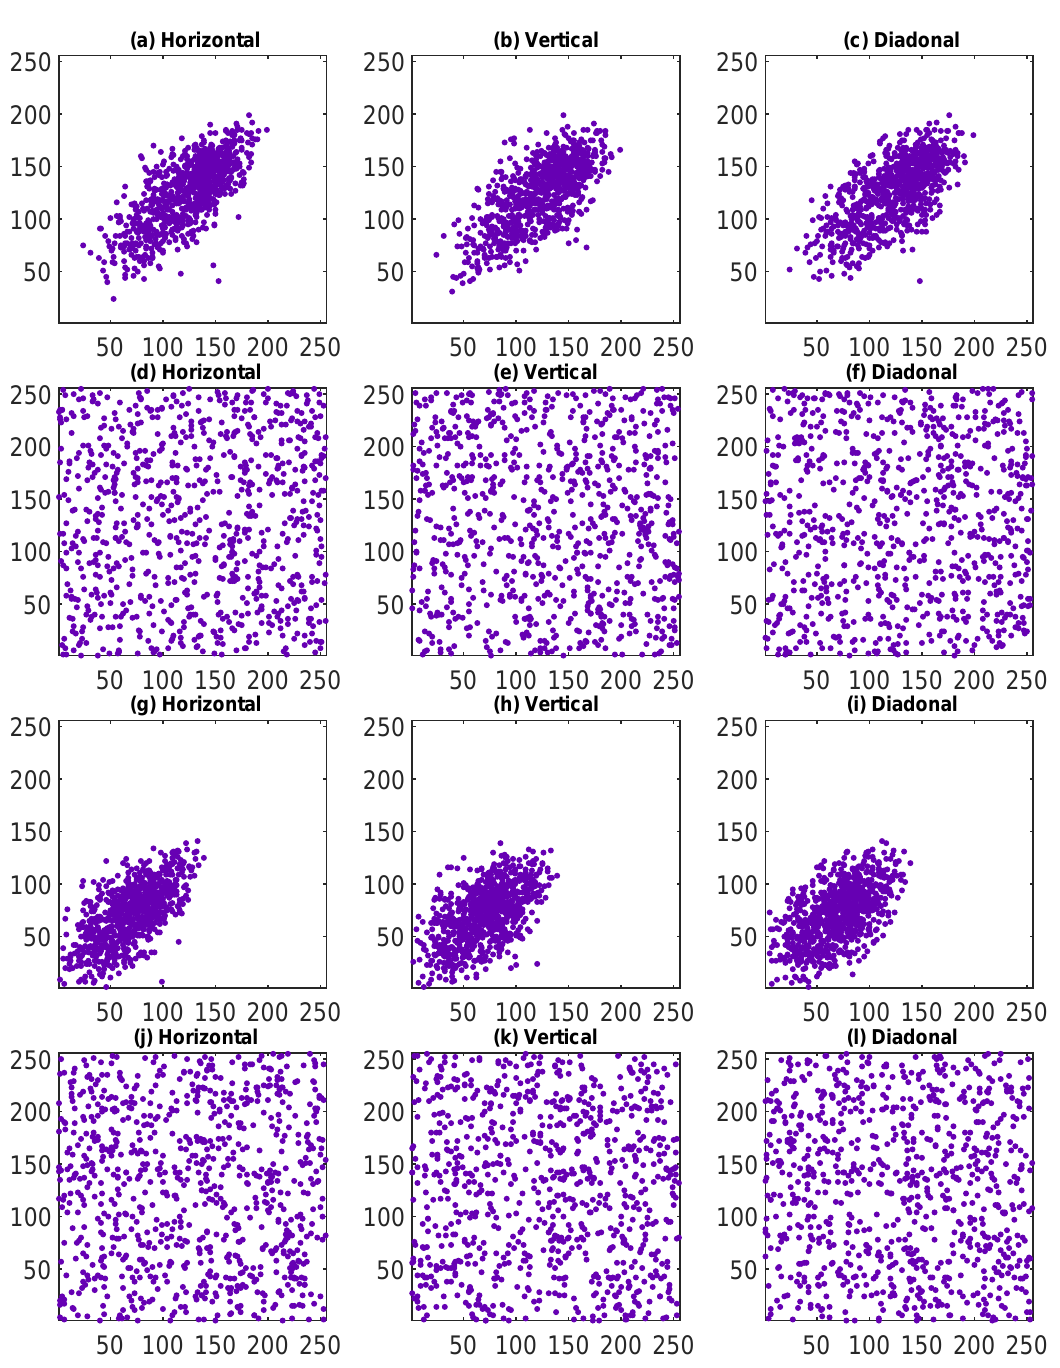
Figure 12. Correlation analysis of grayscale images: ( a – c ) shows the correlation of the input image jet.jpeg, ( d – f ) shows the correlation of the cipher image of jet.jpeg, ( g – i ) shows the correlation of the input image baboon.jpeg, ( j – l ) shows the correlation of the cipher image of baboon.jpeg. All images include the horizontal, vertical, and diagonal